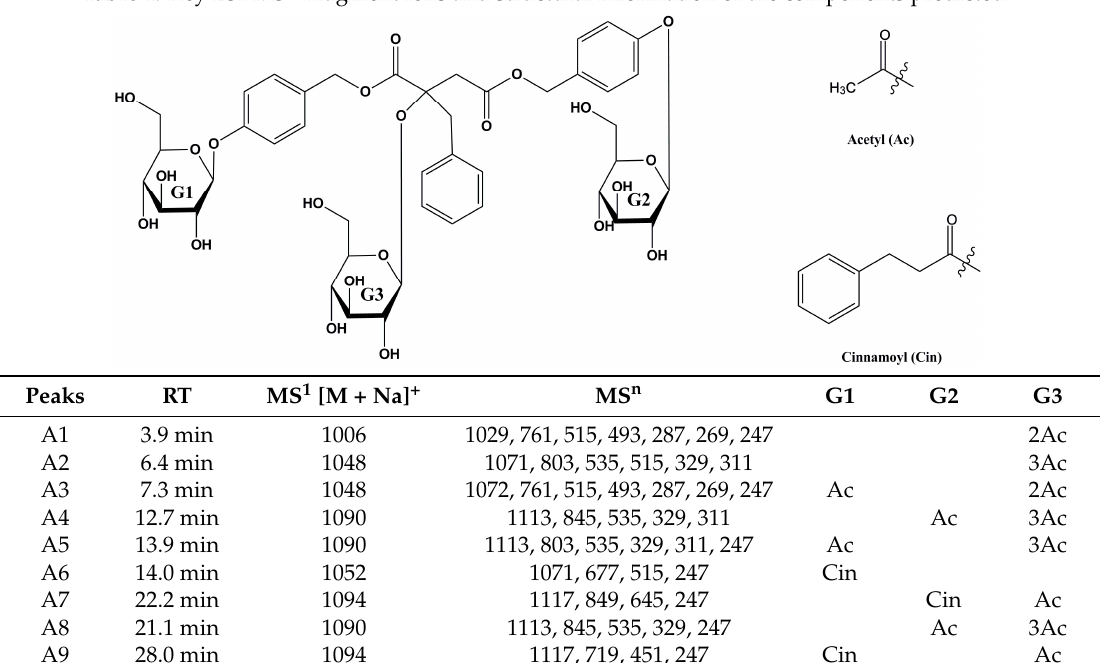
Table 3. HR-ESI-MS and key ESI-MS n data of the isolates 1 – 8 .